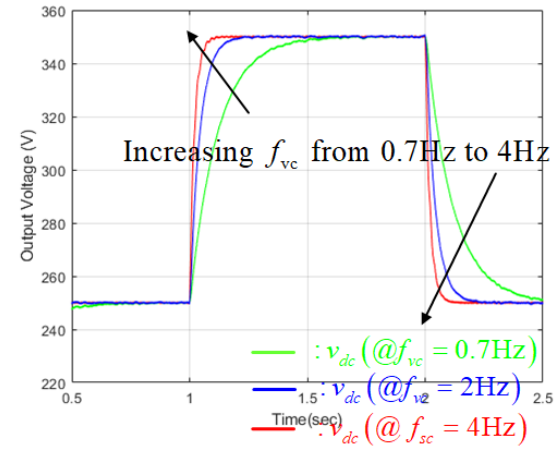
Figure 9. Output voltage tracking performances for several cut-off frequencies, f vc = 0.7,2,4